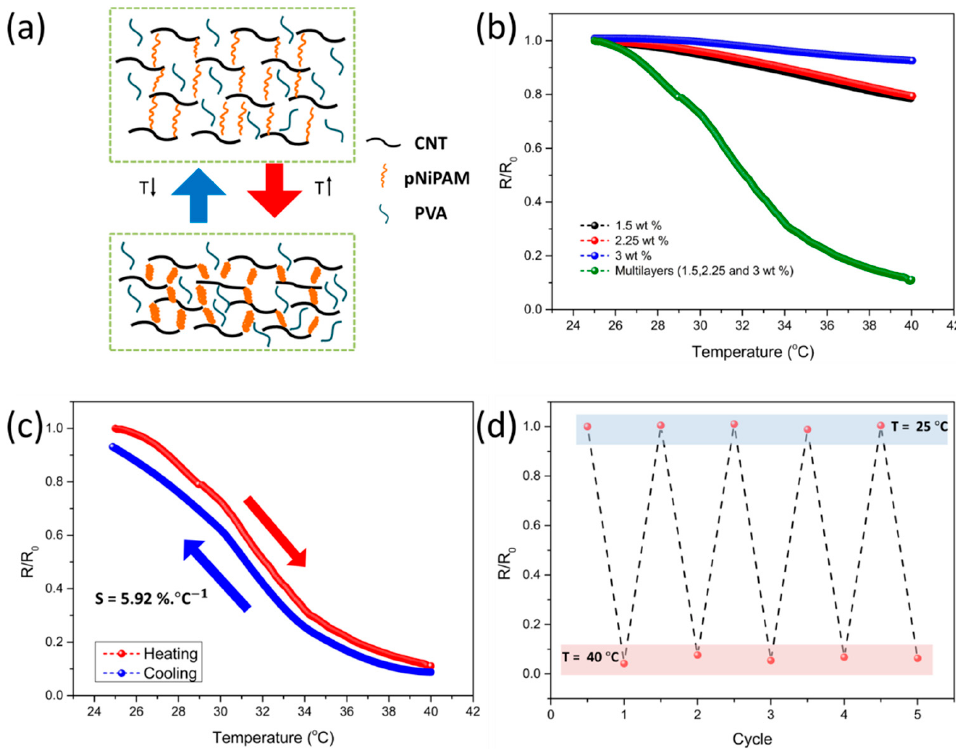
Figure 6. Enhanced temperature-sensing performances of a multilayer sensor with modulus gradi- ent compared to that of a single-layer sensor ( a ) Schematic illustration of the sensing mechanism of PVA/pNIPAM/SWCNTs composites with a change in temperature ( b ) Relative resistance of multi- layer sensor with modulus gradient and single-layer sensor in response to a change in temperature ( c ) Relative resistance changes based on temperature, with increments/decrements rates of 0.43 °C/s and 0.012 °C/s ( d ) Repetitive measurements of the relative resistance changes over five cycles be- tween 25 °C and 40 °C.